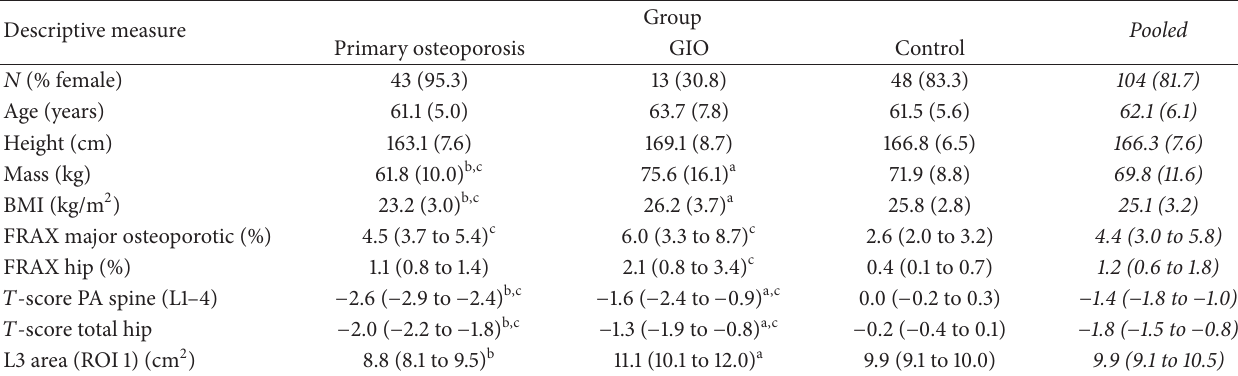
Table 1: Descriptive measures for each group and pooled data, expressed as the mean (SD) for age, height, mass, and BMI and as the mean (95% CI) for FRAX data, 𝑇 -scores, and L3 area.